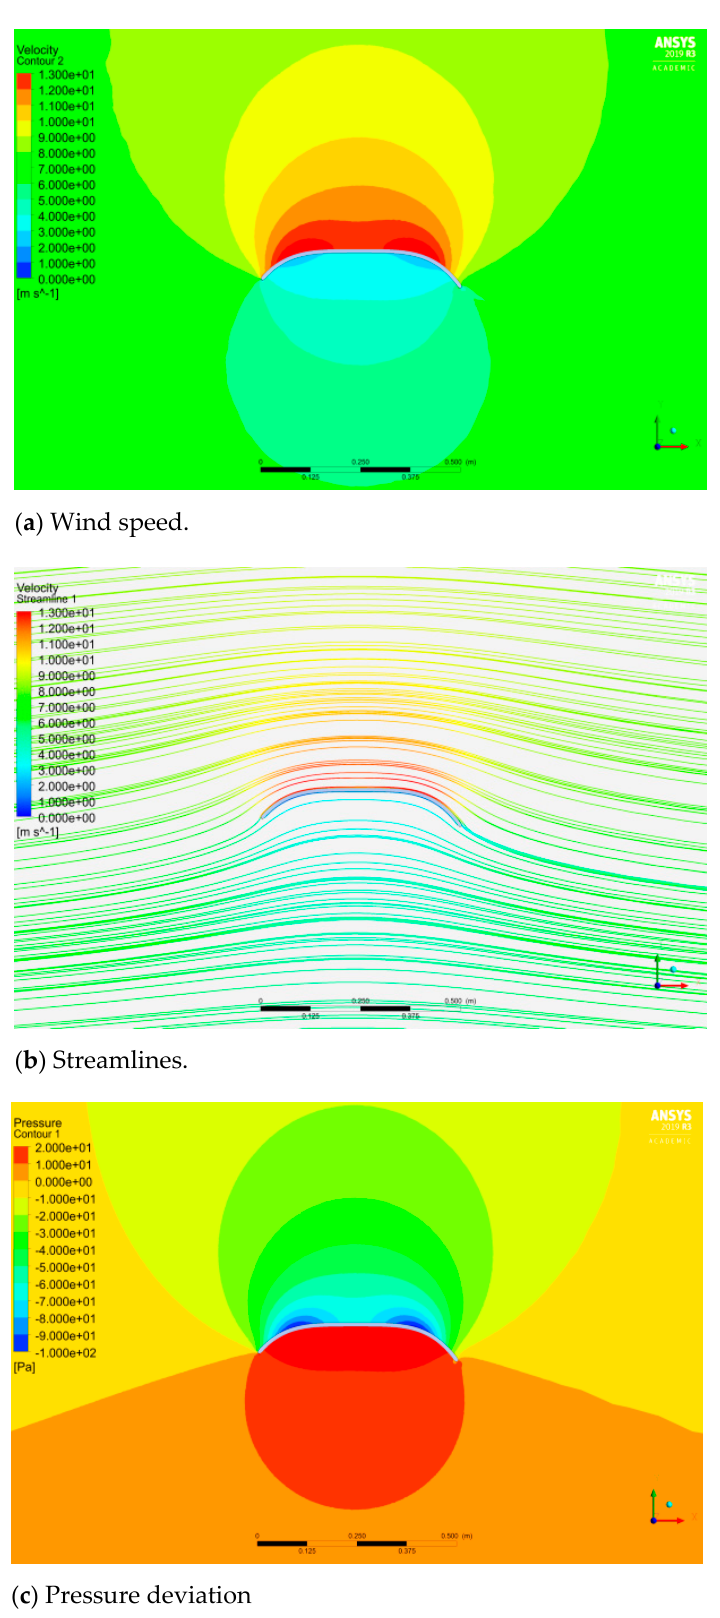
Figure 7. CFD results of the optimal case (B) (7 m/s wind from left, top to inside the diffuser) .